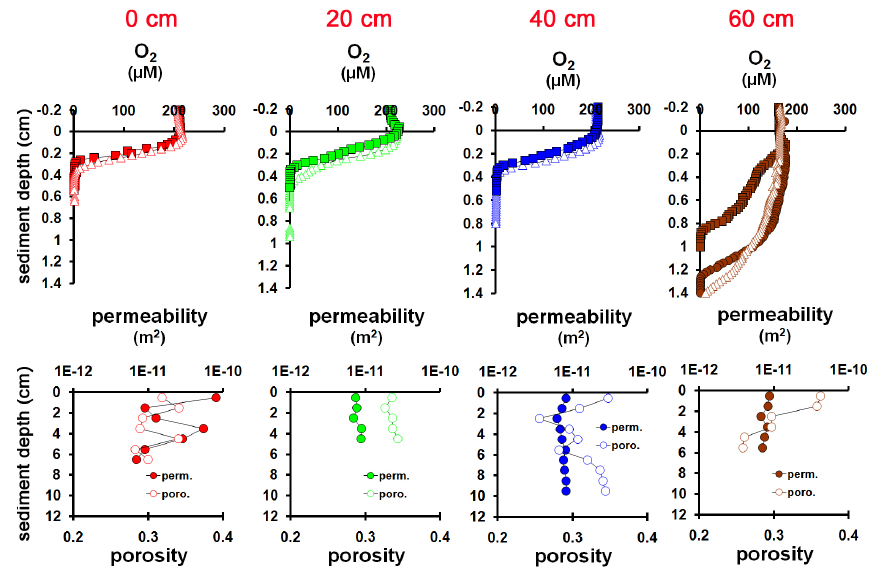
Fig. 2a. Biogeochemical profiles of the November sampling (transect) at Brian Seep: oxygen (2–3 replicates), permeability, and porosity. Distances from gas vent: 0 (red), 20 (green), 40 (blue), and 60cm